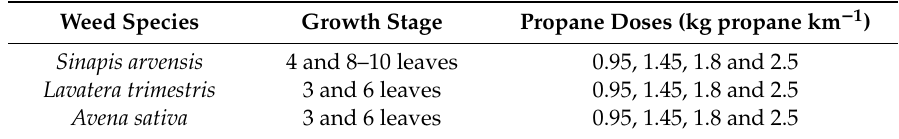
Table 2. Weed species, growth stages and propane doses used in the cross flaming experiment. Weed